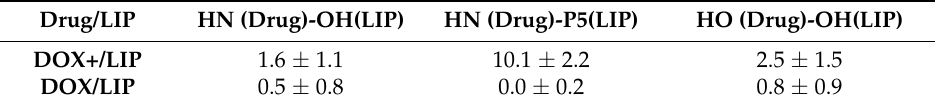
Table 4. Average number of hydrogen bonds per timestep for the examined